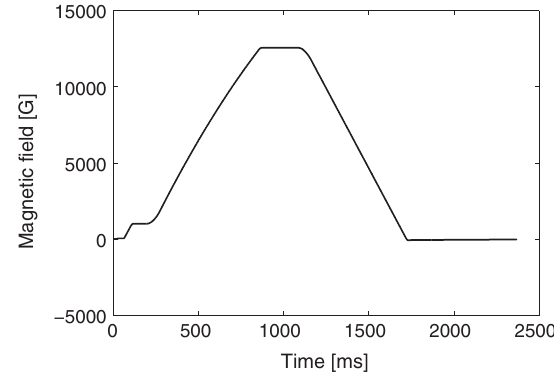
FIG. 1. Magnetic field as a function of time of the 25.48 GeV beam cycle.